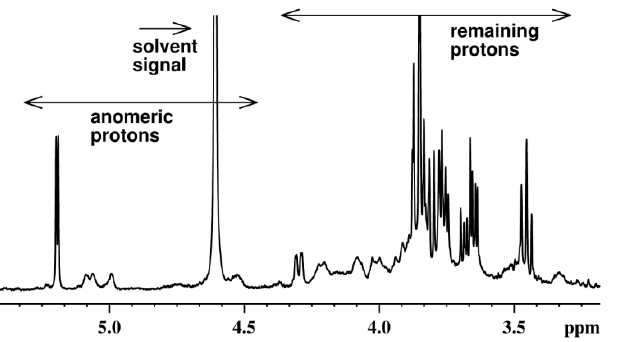
Figure 2. 1 H NMR spectrum of the polysaccharide fraction isolated from S. crispa.